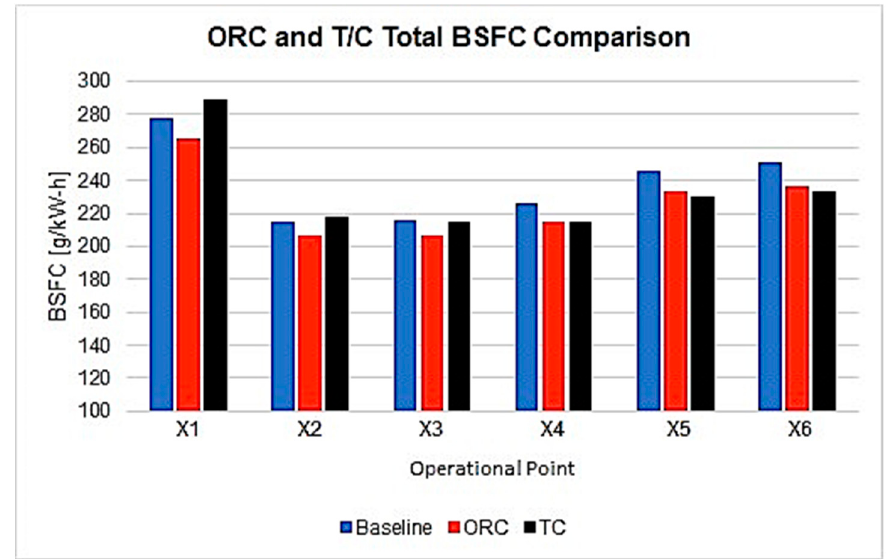
/ C in relation to six individual